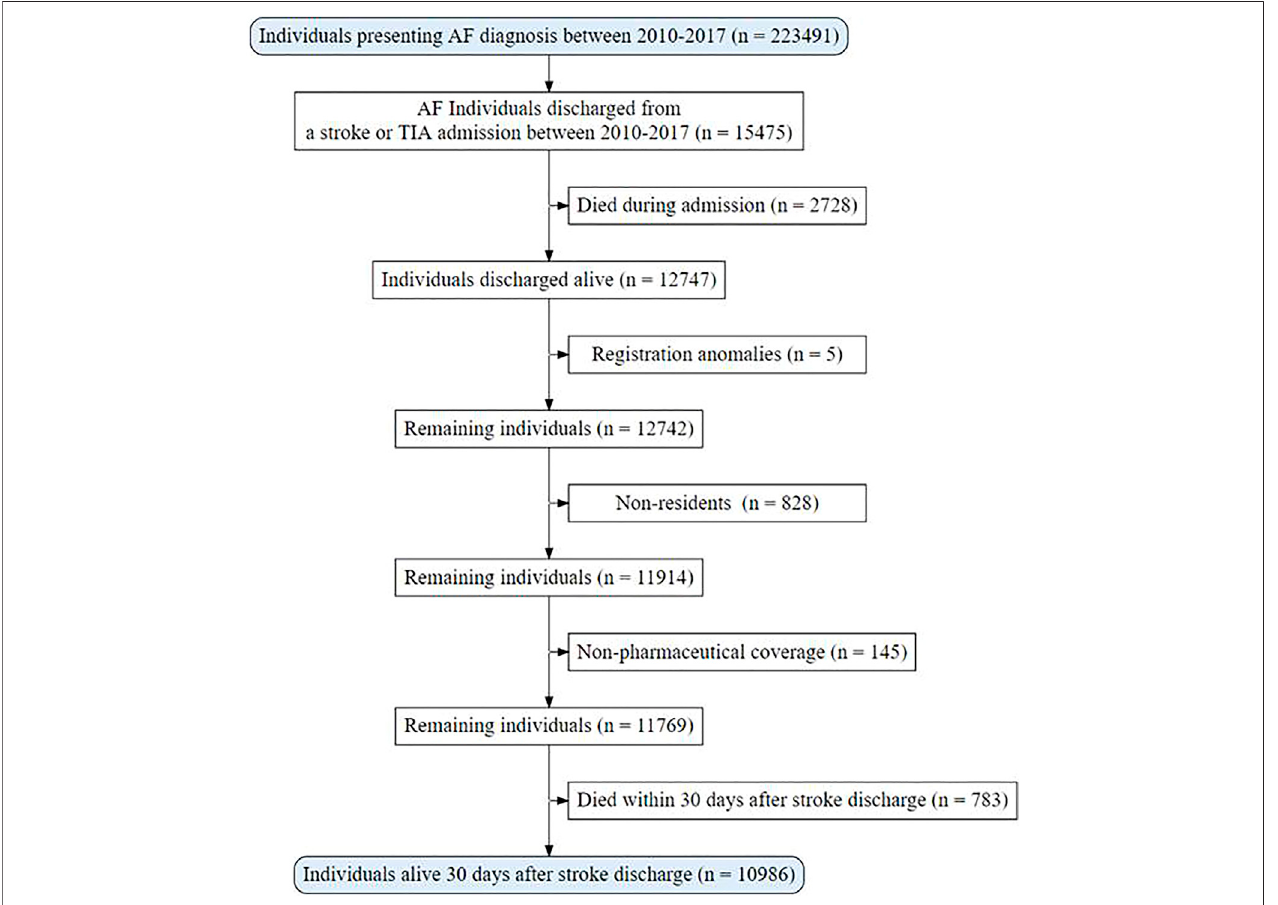
FIGURE 1 | Population fl